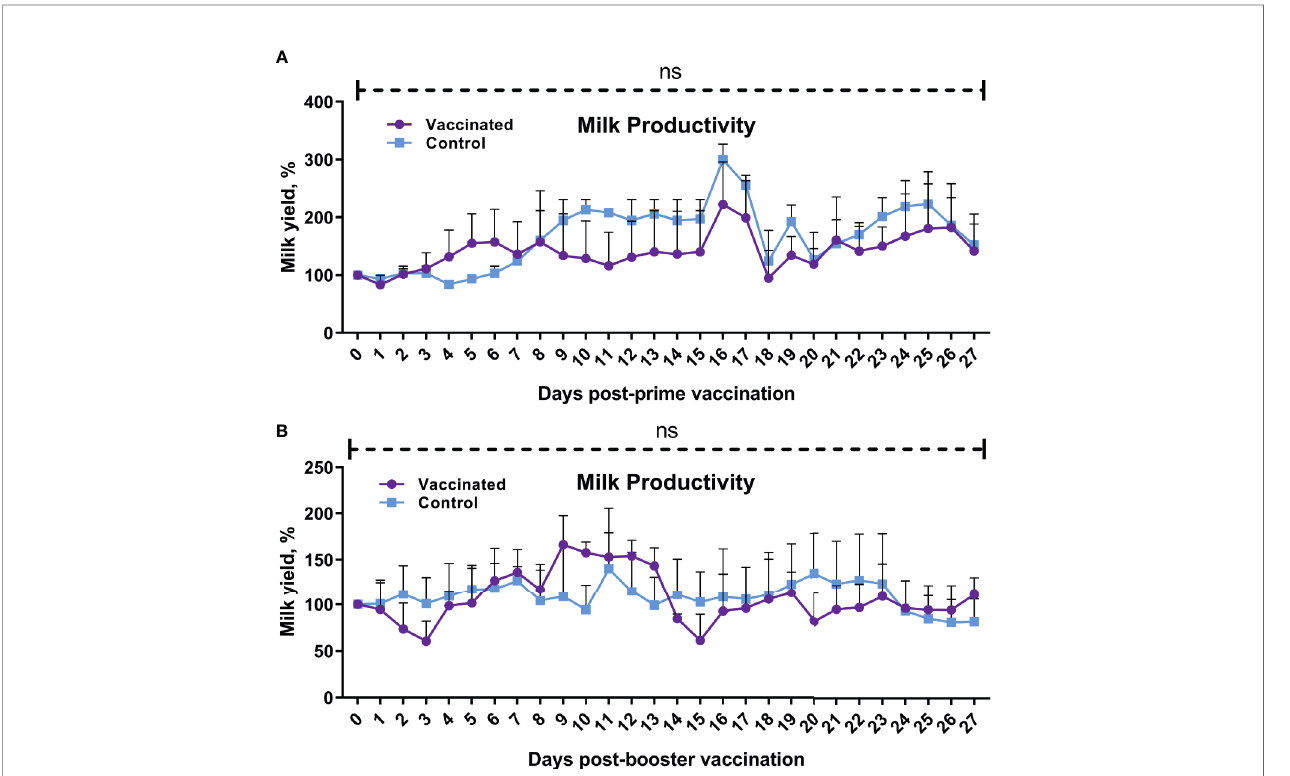
FIGURE 2 | Cow milk yield after prime (A) and booster (B) vaccination. The cows in the vaccinated group were immunized twice via the subcutaneous route at an interval of 28 days with vaccines generated from the IVV subtypes H5N1 (prime vaccination) and H1N1 (booster vaccination). Cows in the control group were subcutaneously injected with 1.0 ml of 20% Montanide Gel01 adjuvant in PBS. Milk yield was expressed as a percentage of the initial volume of milk by 0 days before prime or booster vaccination. The data was presented as means with standard errors (SEM). Ns — P = 0.1850 − > 0.9999 vs . Zero-day milk yield prior to prime or booster vaccination; P = 0.99 − > 0.9999 between vaccinated and control groups. Statistical analysis was performed using two-way ANOVA followed by Tukey ’ s or Sidak ’ s multiple comparisons test. P values < 0.05 were considered signi fi